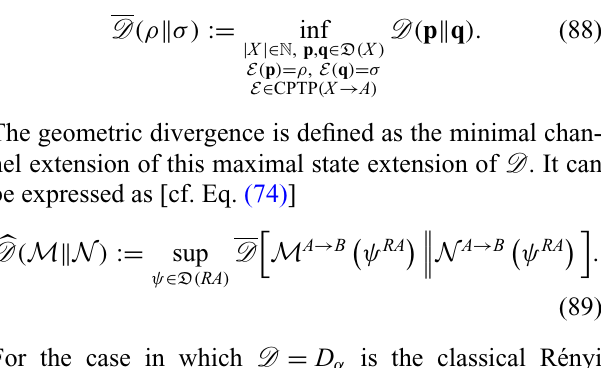
FIG. 3. The order between extensions and regularizations mat-